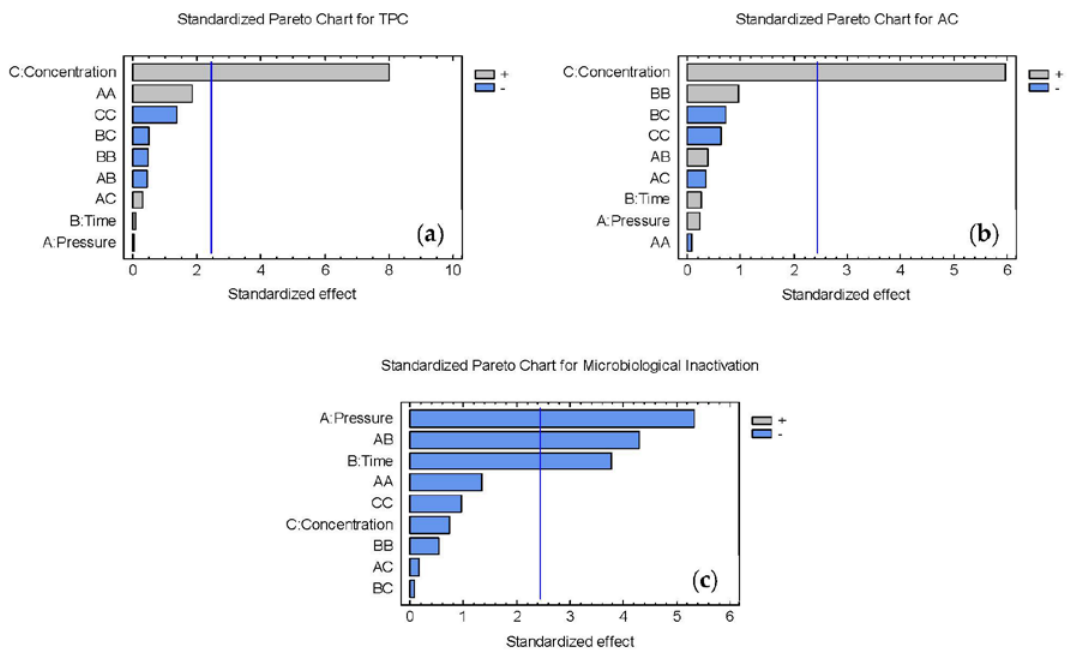
Figure 3. Estimated effects of each factor (pressure, time, and concentration) and their interactions with TPC ( a ), AC ( b ), and L. monocytogenes inactivation ( c ) where + or − means a positive or negative relation between factor (pressure, time or concentration) and response (TPC, AC or L. monocytogenes survival fraction), respectively. A: pressure, B: time and C: concentration. The combination of letters (AA, BB, AB …) refer to the interactions carried out in the analysis.